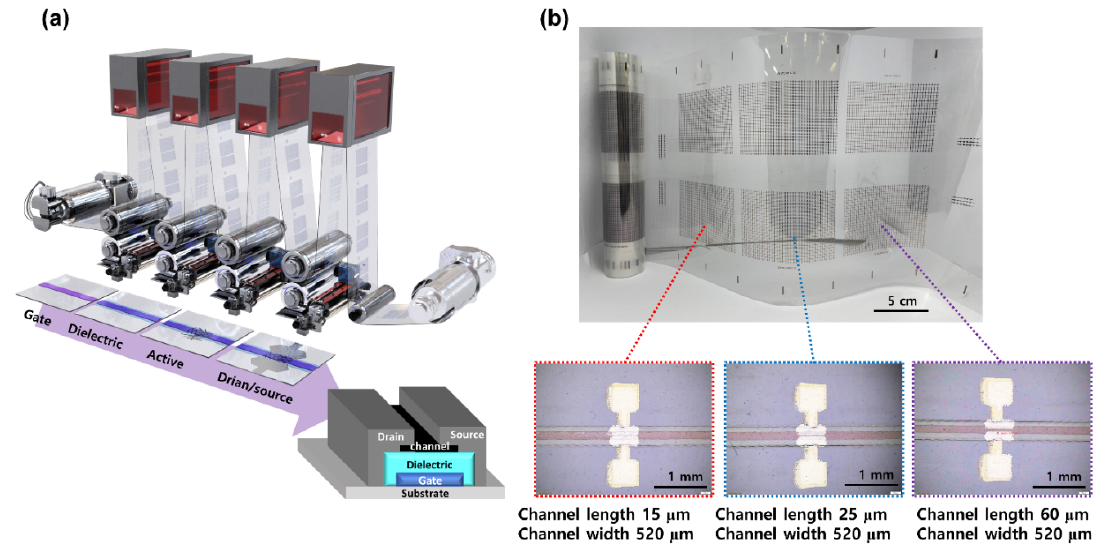
Figure 5. ( a ) Artistic rendering of the R2R gravure printing process for fabricating a 26 × 38 SWCNT-TFT array. ( b ) Roll image of R2R gravure printed 26 × 38 SWCNT-TFT arrays and the enlarged optical images of SWCNT-TFT with three different channel lengths (15, 25, and 60 µm). To the printed 26 × 38 SWCNT-TFT array, the base and fastening cover were positioned and fastened, as shown in Figure 3a. The PICR2R-TFT probe head was mounted on